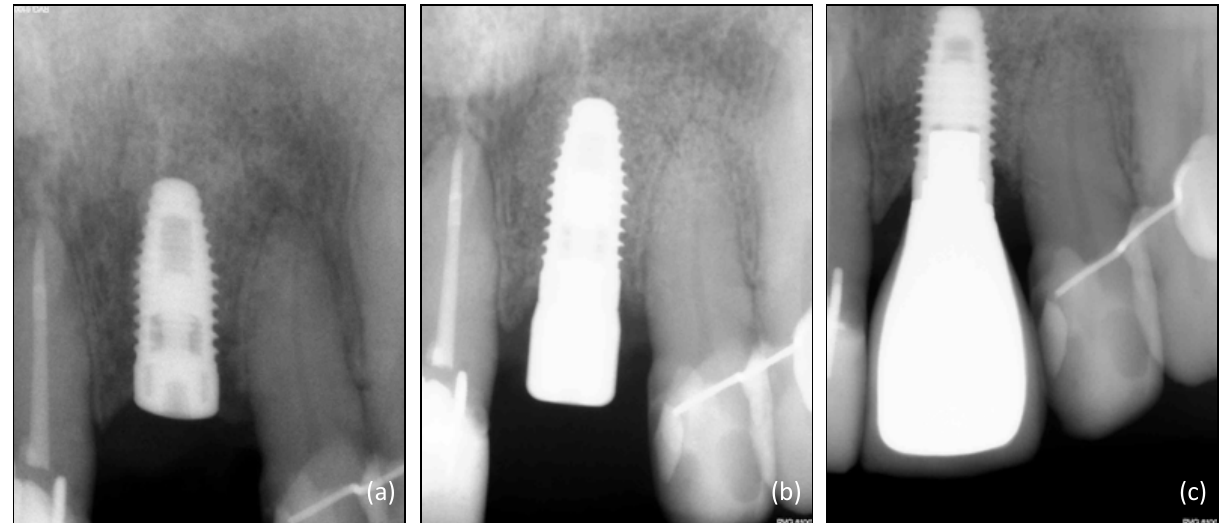
Figure 12. (a) Stage 1 implant surgery. (b) Stage 2 implant surgery. (c) Final restorative implant demonstrating successful